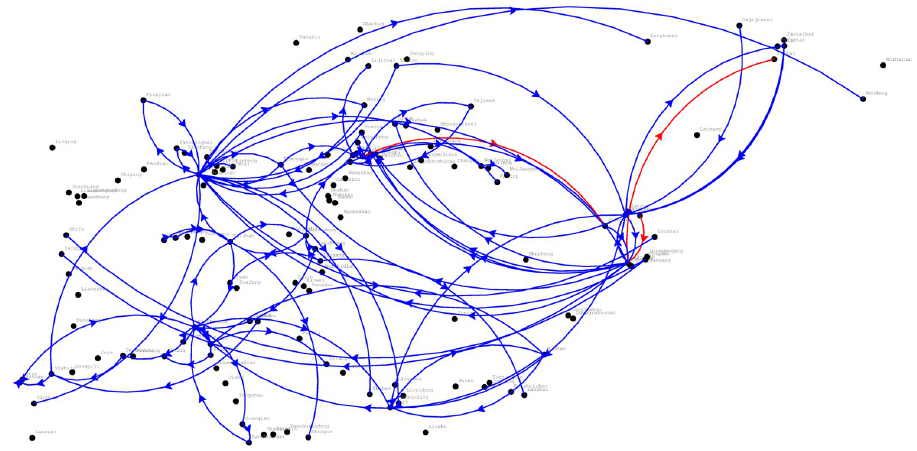
Fig 5. Optimized train service network.